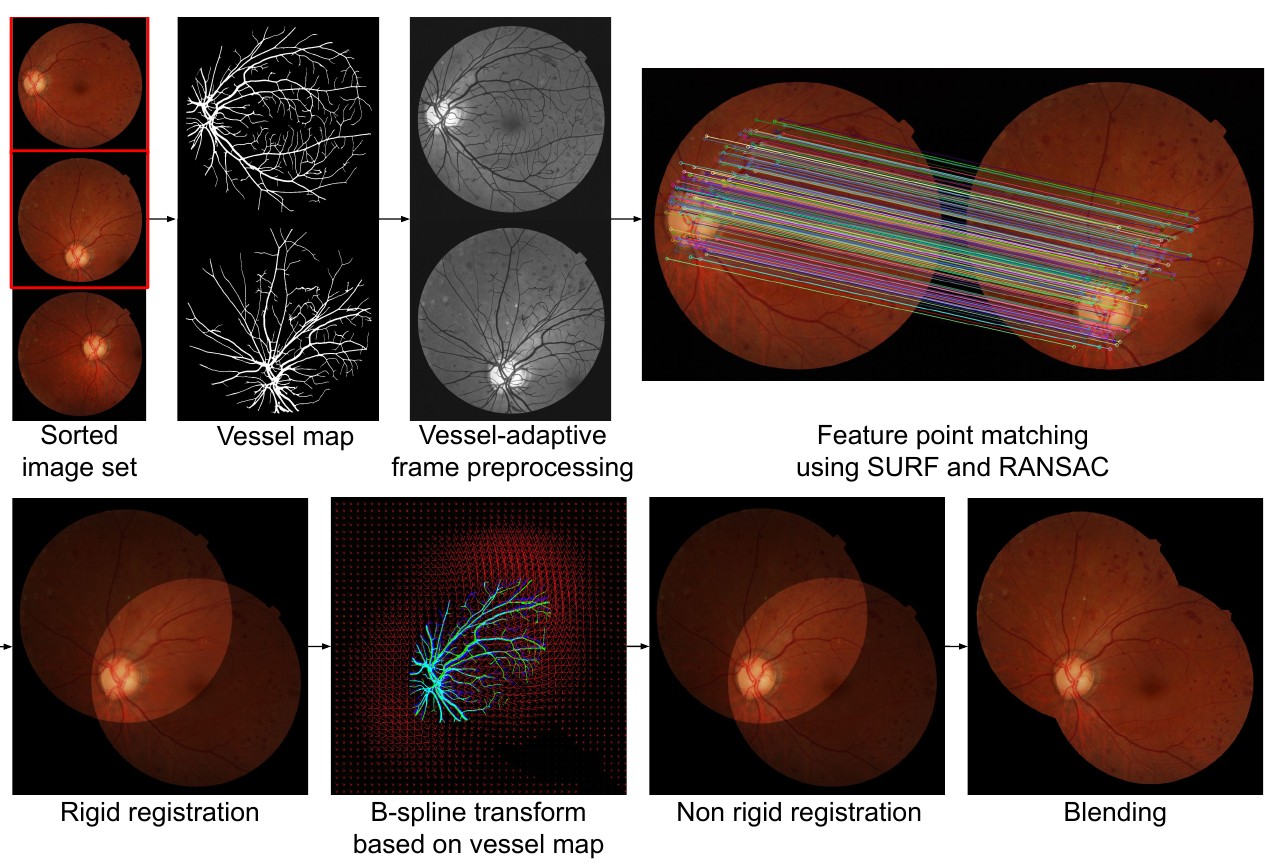
Figure 3. A visual summary of the frame integration pipeline, including a two-step rigid and non-rigid registration method adapted from [15], together with image